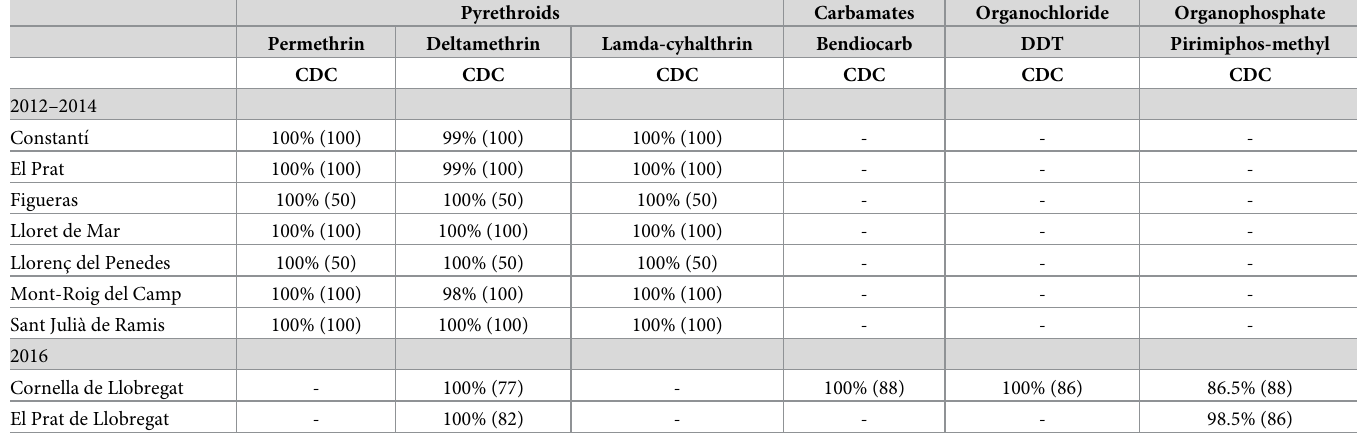
Table 3. Insecticide susceptibility of Ae . albopictus collected from various localities in Catalunya (Spain). Percentage indicates percent mortality at discriminating exposure time of 30 min (45 min for DDT); number between parentheses indicates the number of mosquitoes tested.